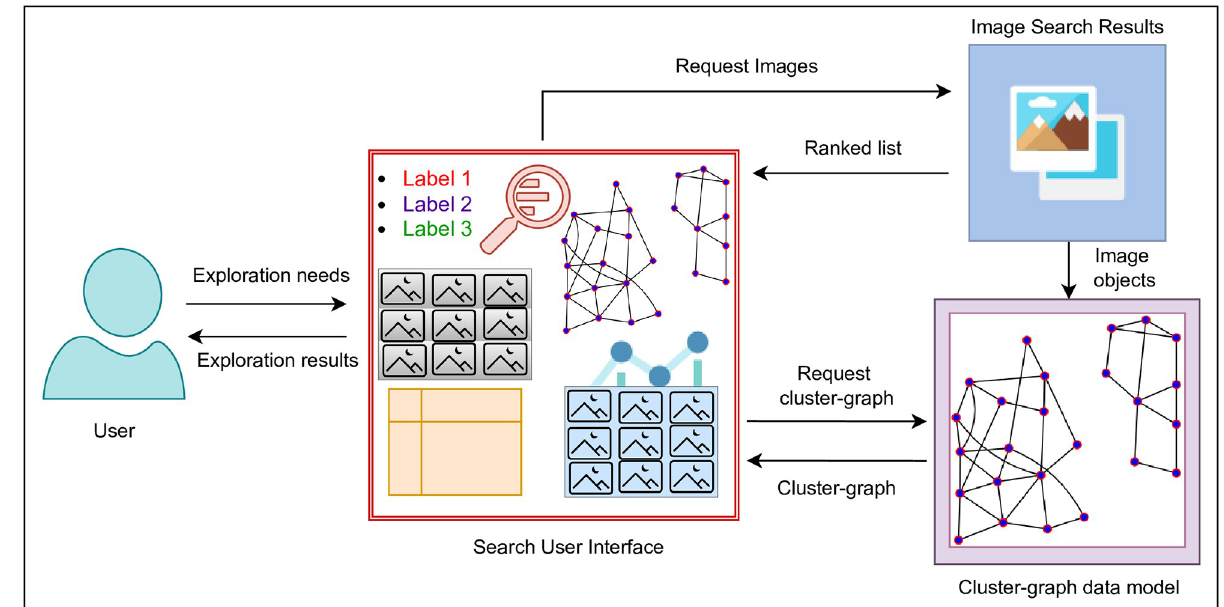
Fig 2. An overview of the proposed approach.